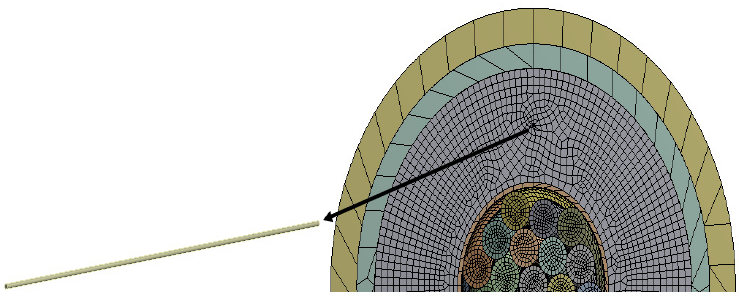
Figure 8. Placement of linear FOS 4 mm inside XLPE. From Figure 9, different color schemes of linear-placed FOS can be observed. The blue color scheme refers to FOS placed parallel to the central wire, whereas the other color schemes of green, pink, and orange refer to the FOS embedded inside the XLPE insulator over the thickness. The length considered in all simulations is 40 mm, which corresponds to the helical